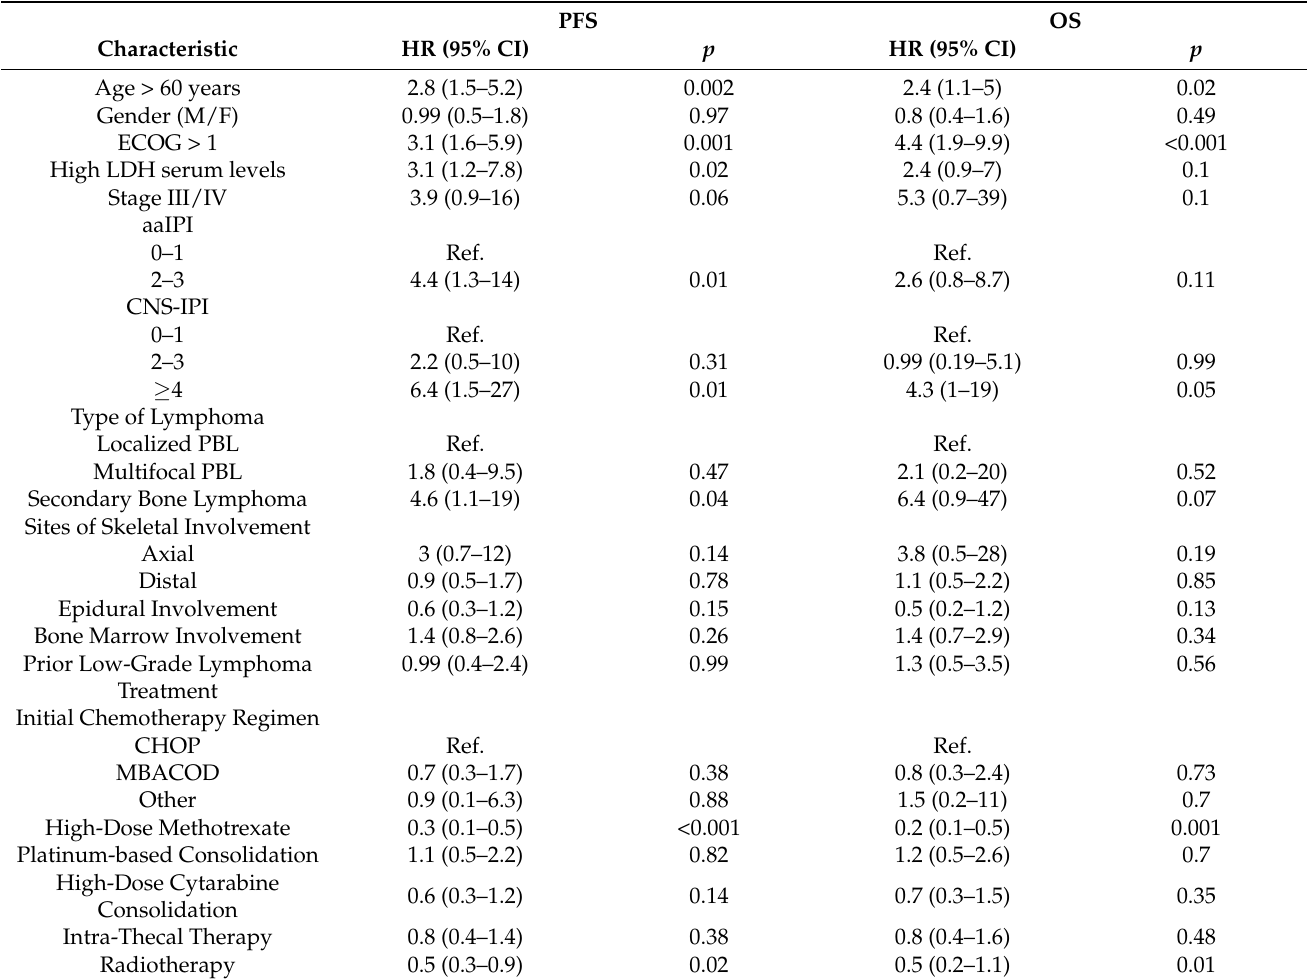
Table 3. Univariable analysis of factors associated with PFS and